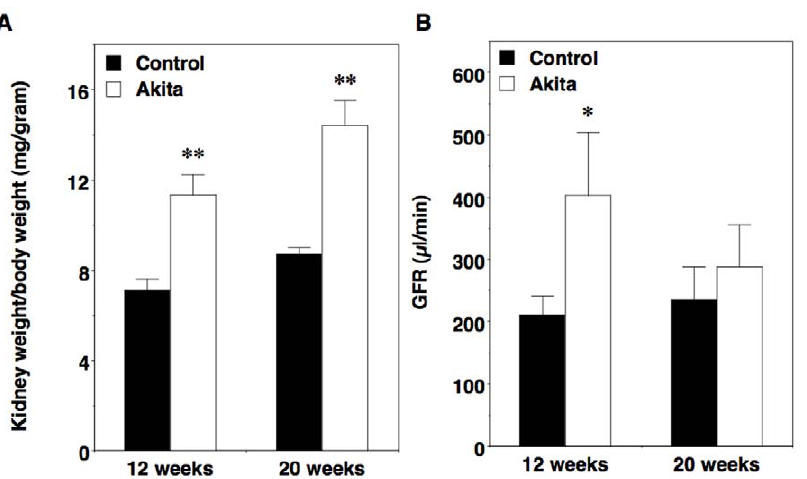
Figure 3. Kidney weight and glomerular filtration rate (GFR) in male Akita mice. (A) Kidney-to-body weight ratio was significantly increased in diabetic Akita mice (n=6 to 8) compared to controls (n=6 to 8) at 12 and 20 weeks of age. (B) There was a significant increase in GFR at 12 weeks of age in diabetic Akita mice (n=3 to 5) compared to controls (n=5). Black bars=control; white bars=Akita. Data are mean 6 SEM. *P , 0.05 or **P , 0.001 vs. age-matched controls.